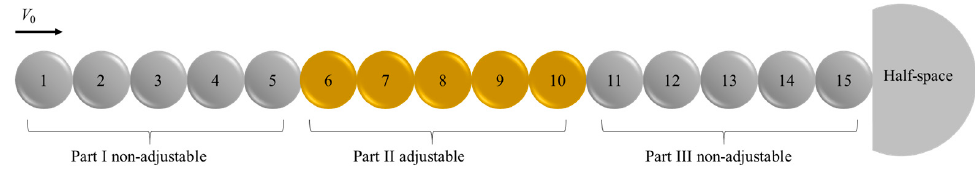
Figure 1. Schematic diagram of the one ‐ dimensional three ‐ segment composite granular chain.